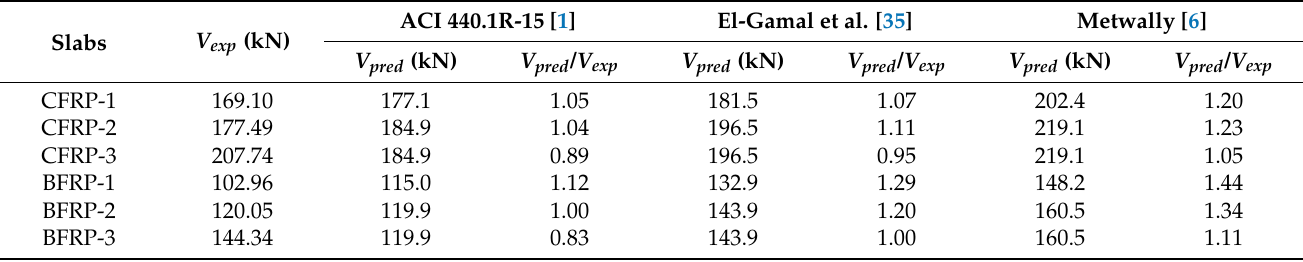
Table 9. Experimental and theoretical punching shear capacity of the CFRP- and BFRP-RC slabs based on different analytical